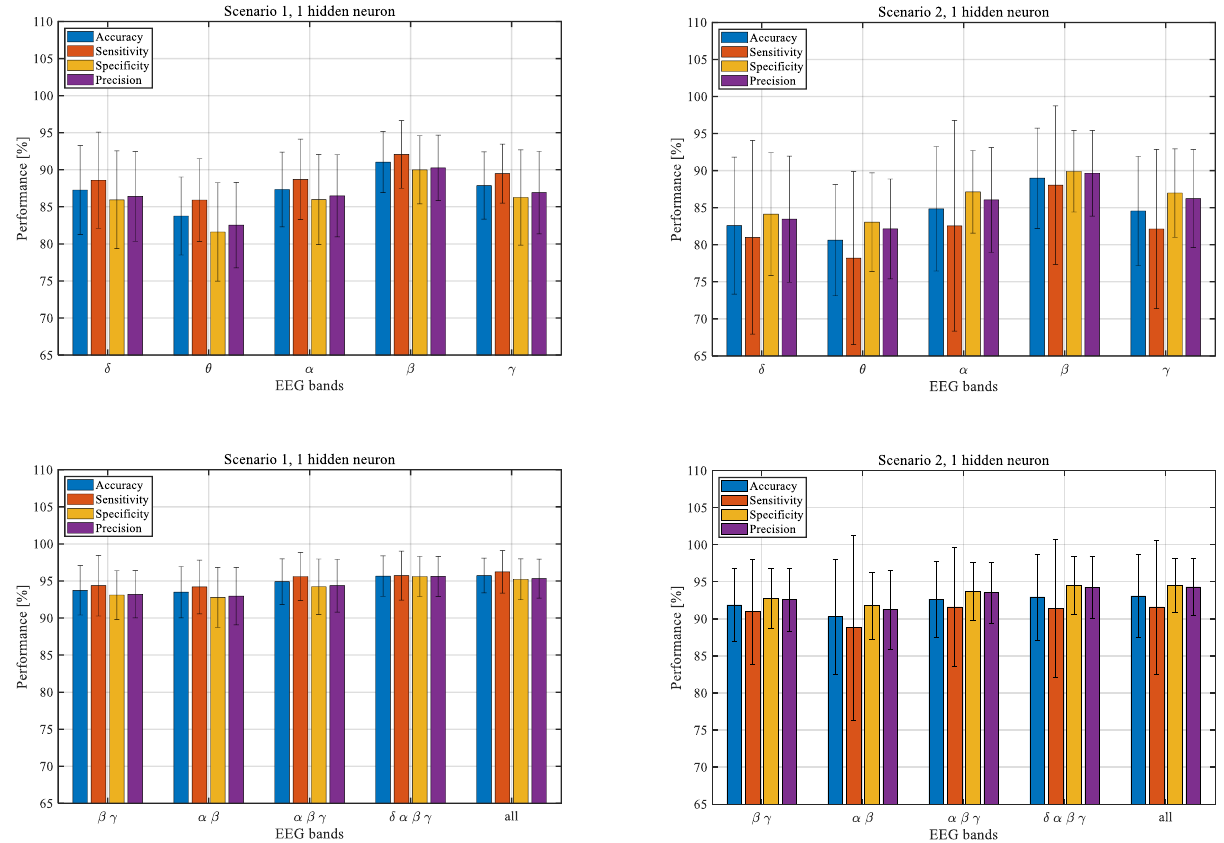
Figure 5. Performance of the system with one hidden neuron for EEG frequency bands for the first ( left ) and the second ( right ) scenario.